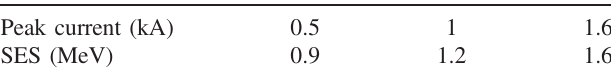
TABLE I. Measured SES (rms) at 4.3 GeV, 180 pC with nominal laser heater setting (20 keV induced spread). Peak current is measured in the center of the